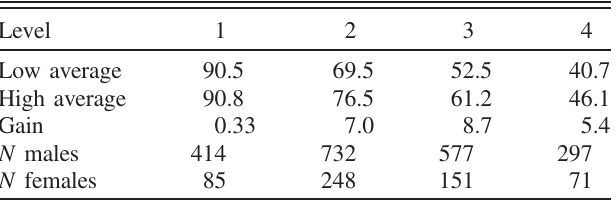
TABLE V. Average performance by level on exam questions assigned to the low and high scaffolding groups. Gain represents the increase in average exam score as a result of increased scaffolding. N represents the total number of students achieving each level by gender.